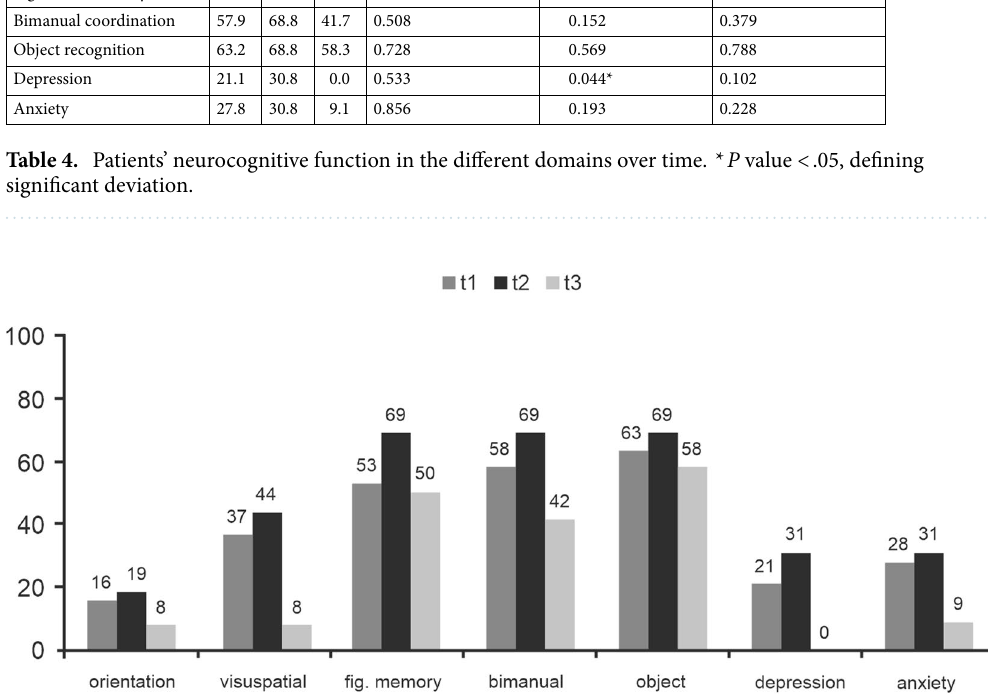
Figure 4. Domains, for which no normative data were available. Percentage of patients impaired per domain, considered as a decrease in a Z-score of more than 1.5 SD, at time points t1 (prior to surgery), t2 (before hospital discharge) and t3 (at long-term